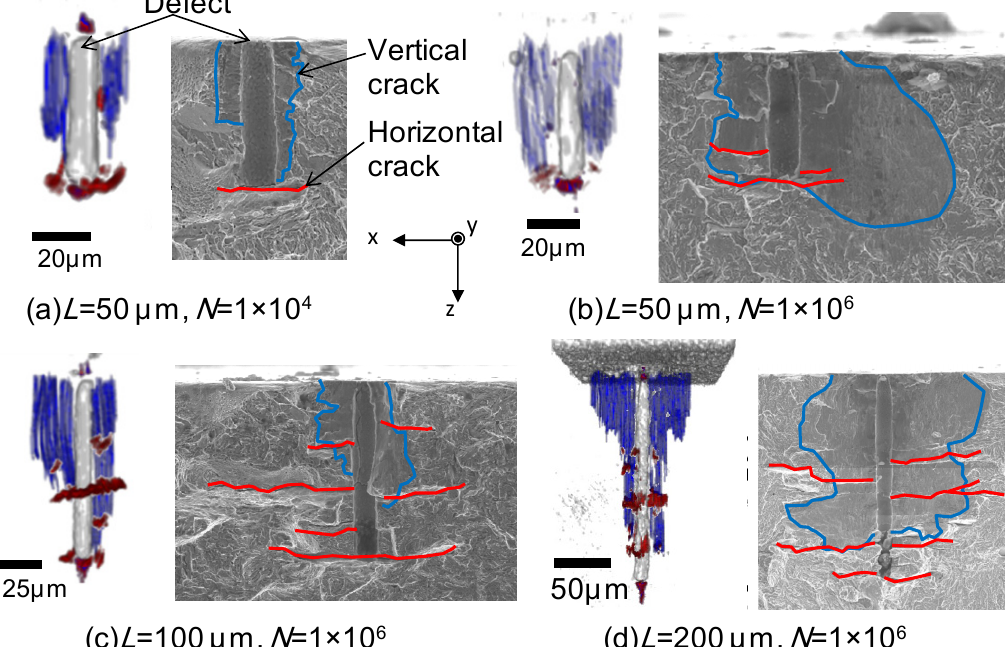
Figure 3: CT images and SEM view of artificial defect and cracks (Defect diameter: 15 μ m, Left: CT image, and Right: SEM view). CT Imaging